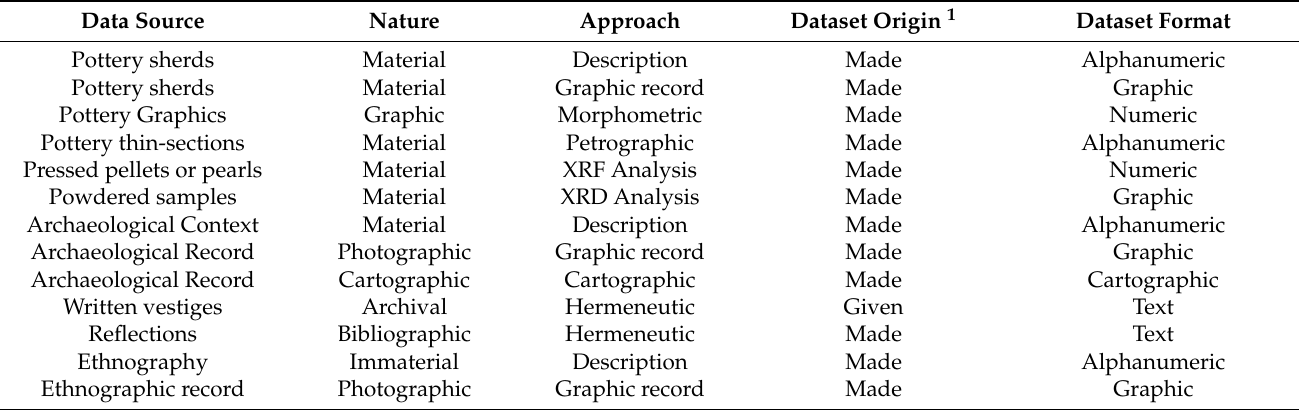
Table 1. Summary table of data sources and the correlation of datasets according to the nature of the vestige, the developed research approach and the origin and format of the originated